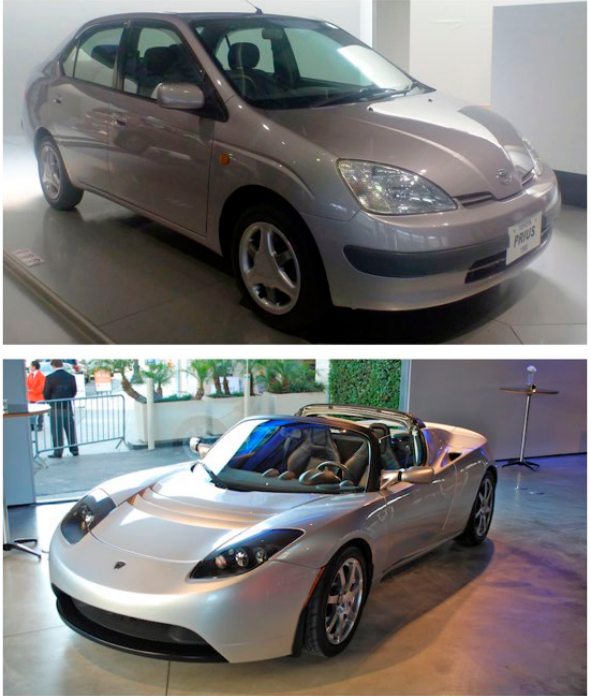
Figure 2. The slow rebirth of electric vehicles: the first hybrid Toyo- ta Prius (1997, top) and the Tesla Roadster (2008, bottom).